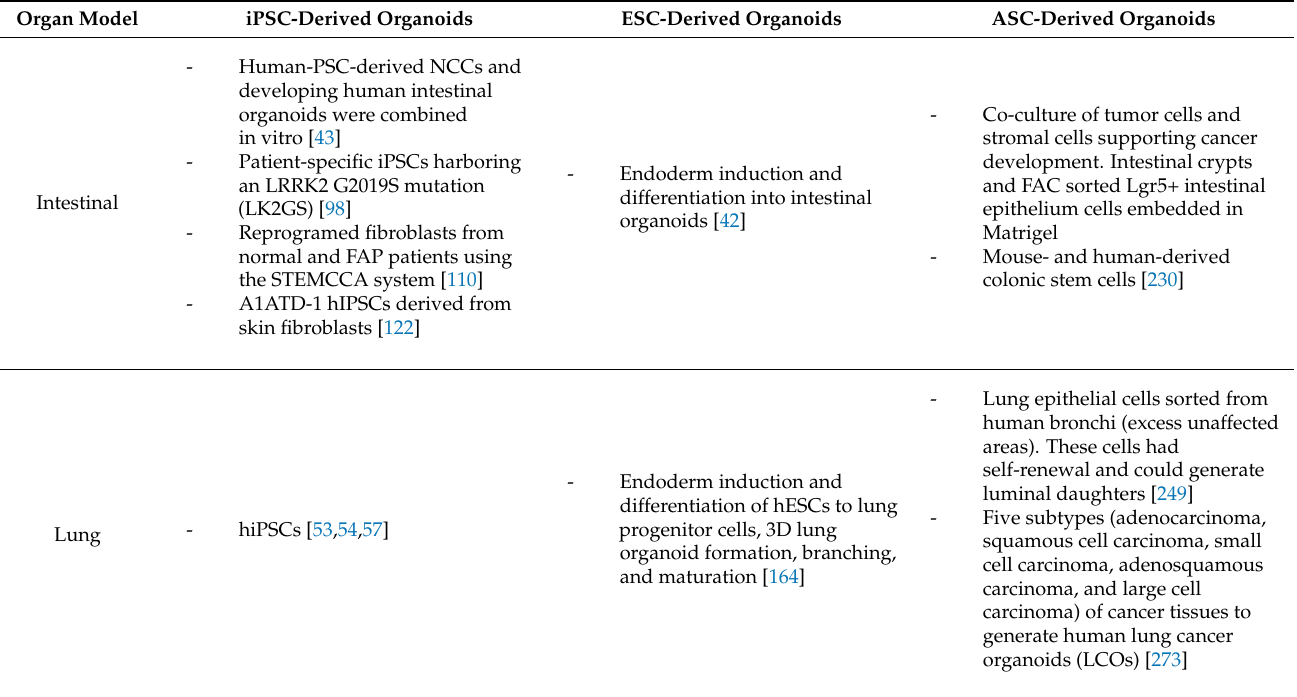
Table 1. Differences in generation methods of several organoid models based on the source of